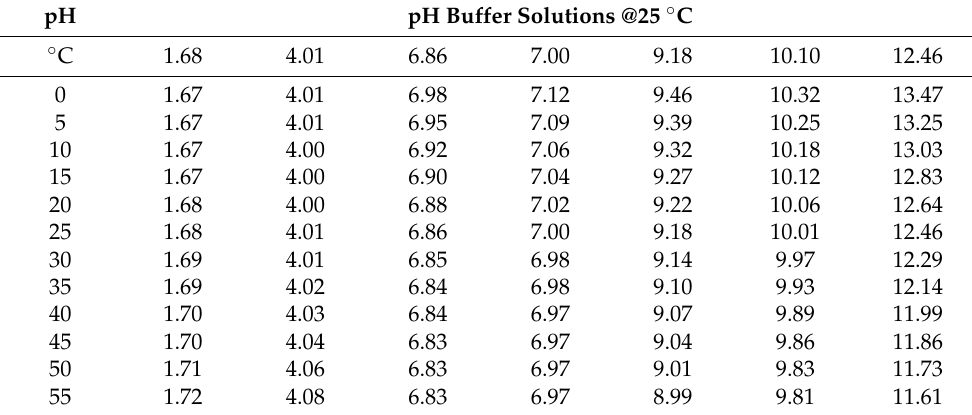
Table 2. Look-up table for temperature-related modification of pH buffer